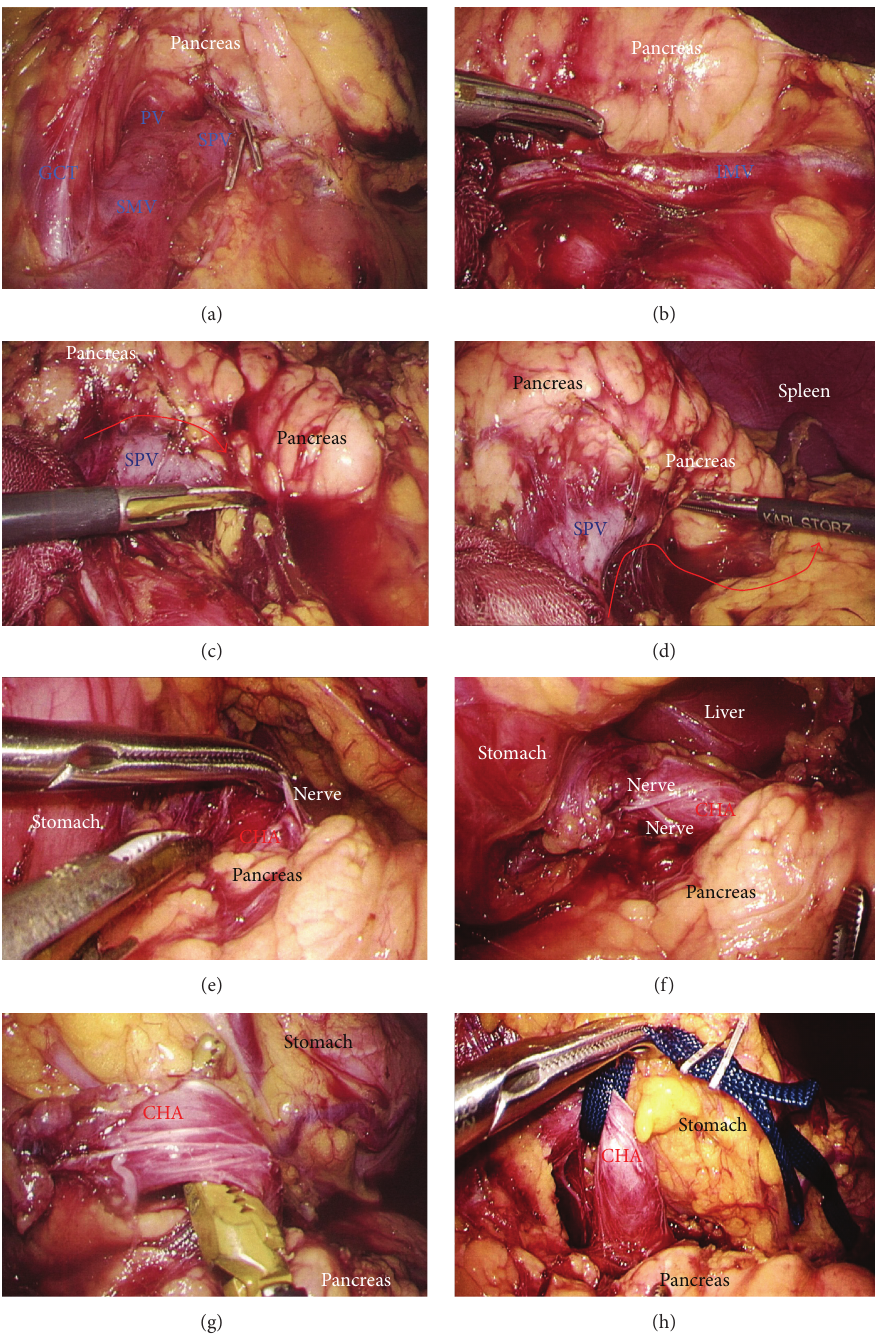
Figure 5: (a) The GCT was visualized. (b) The IMV was then skeletonized and preserved. (c) The SPV was skeletonized from the pancreatic parenchyma (red arrow). (d) The SPV was separated from dorsal fixation by connective tissue (red arrow). (e) and (f) The nerve surrounding the arterial sheath was useful to grasp the CHA without arterial injury. (g) and (h) The CHA was skeletonized and taped. CHA, common hepatic artery; GCT, gastrocolic trunk; IMV, inferior mesenteric vein; SPV, splenic